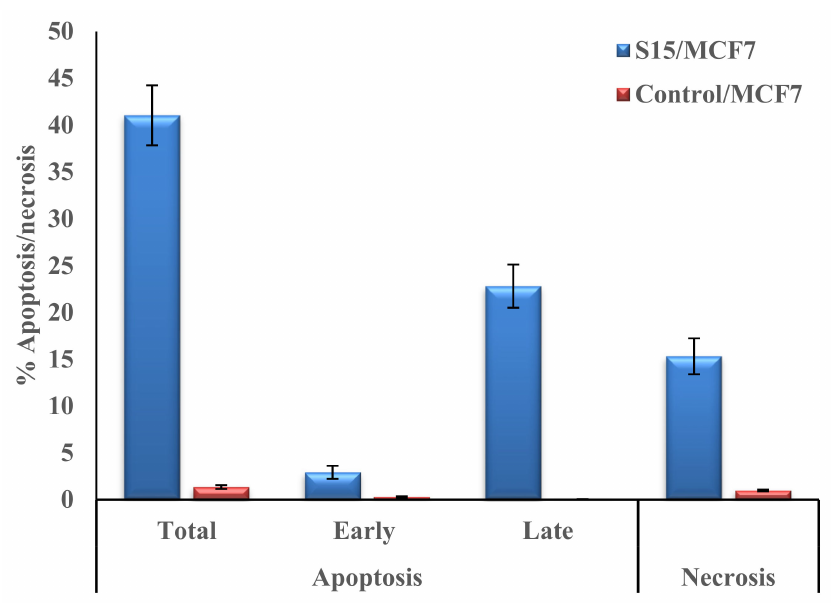
Figure 6. Effect of treatment of MCF7 cancer cell line with compound S15 on the percentage cell necrosis and apoptosis. Data expressed as mean ±